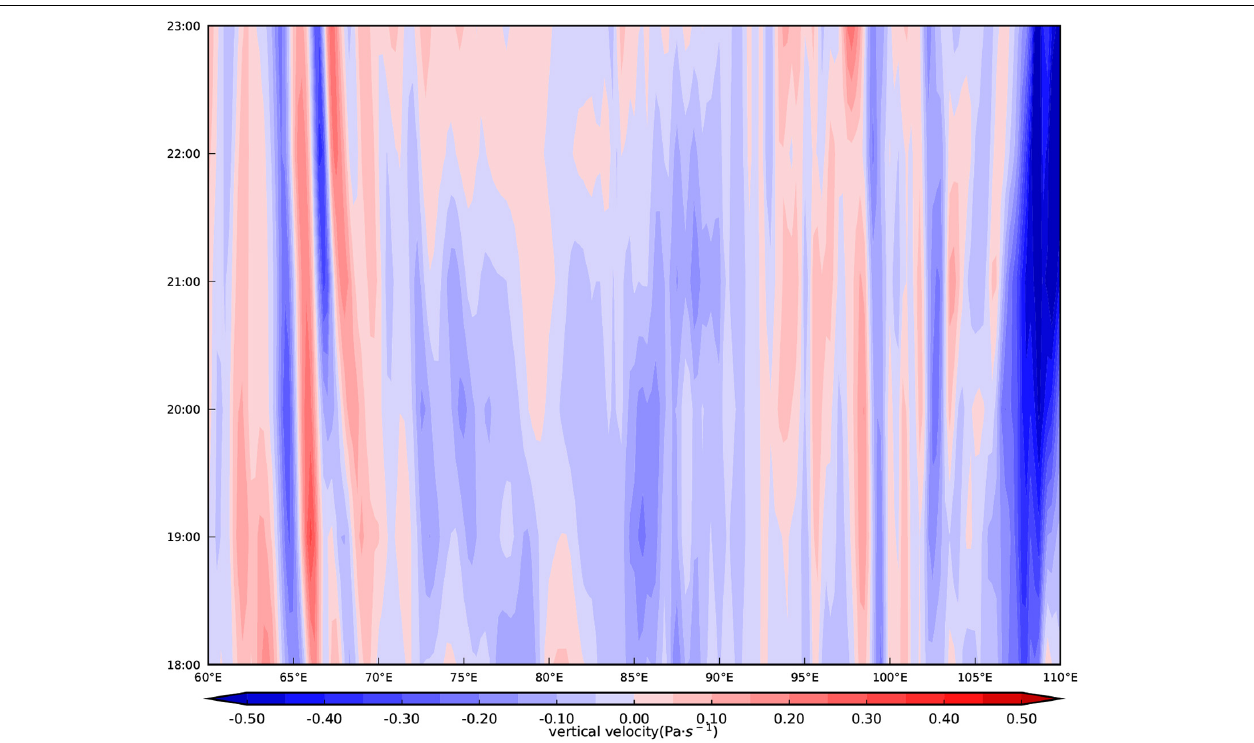
FIGURE 4 | The time evolution of vertical velocity (unit: Pa s − 1 ) with longitude over 28 ◦ N from ERA5 for the period 18:00–23:00 on 3 May, 2014 at 200 hPa.